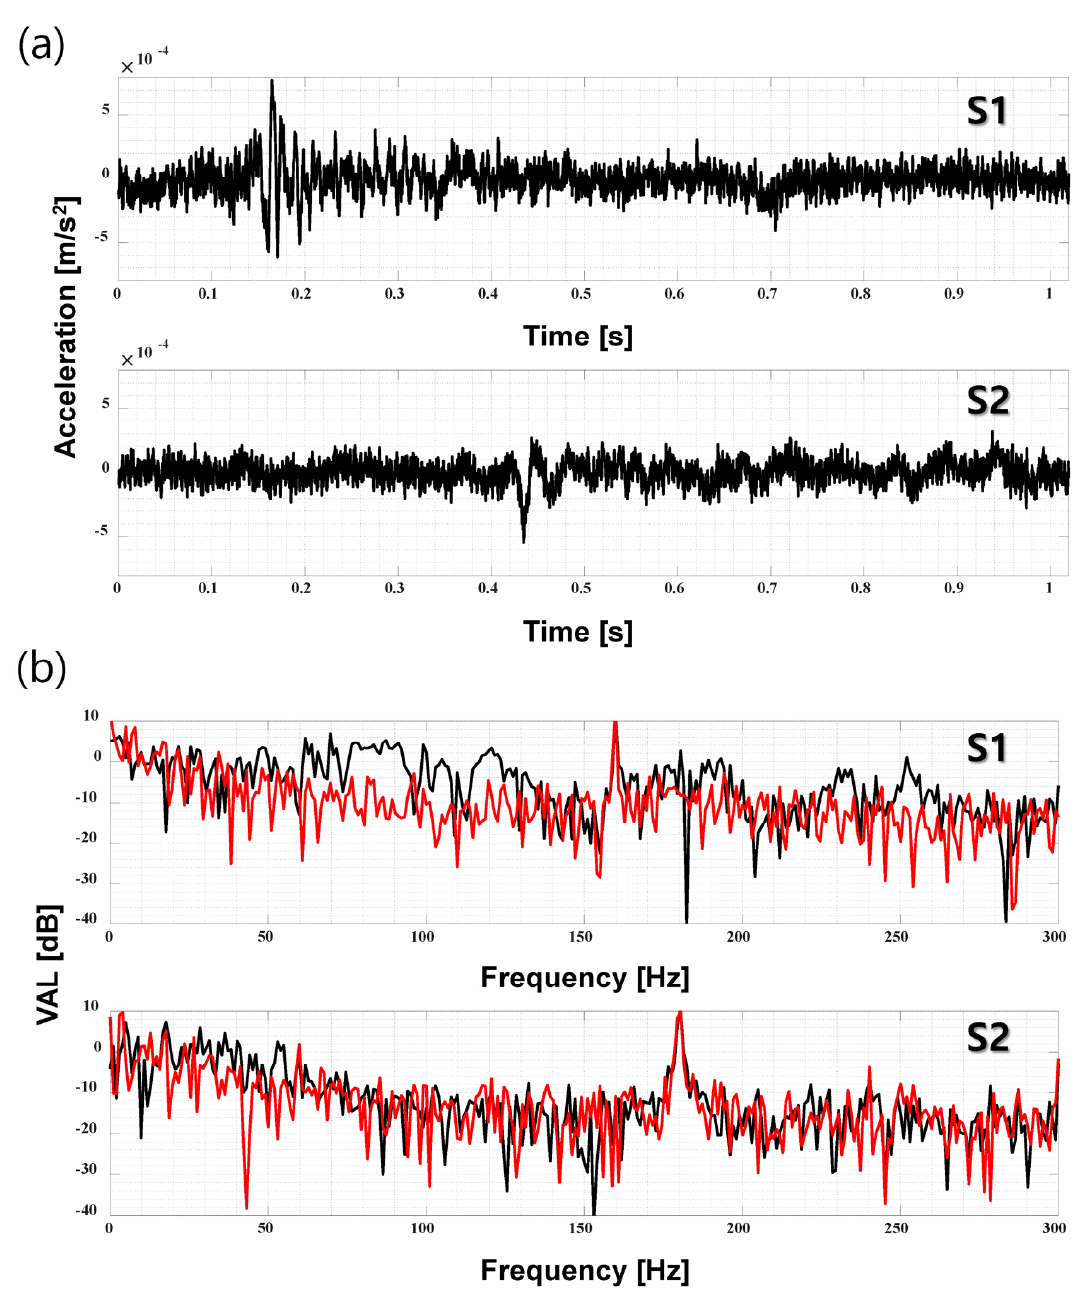
Figure 7. Vibration signals measured at S1 and S2 and their frequency responses; ( a ) vibration accelerations, ( b ) frequency responses of the acceleration signals in black and background noises in red (VAL: Vibration Acceleration Level, dB re 1 µ m/s 2